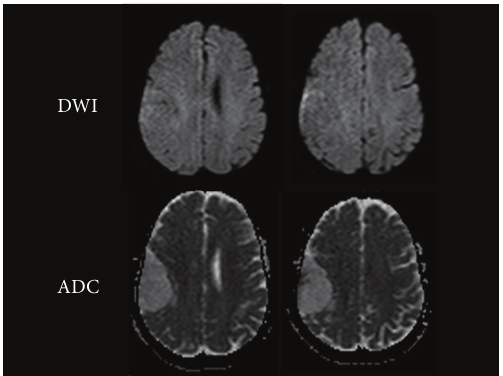
Figure 3: Diffusion-weighted image (DWI) and apparent diffusion coefficient (ADC) map image. The cystic portion of the lesion shows facilitated diffusion, although slightly more restricted than CSF.